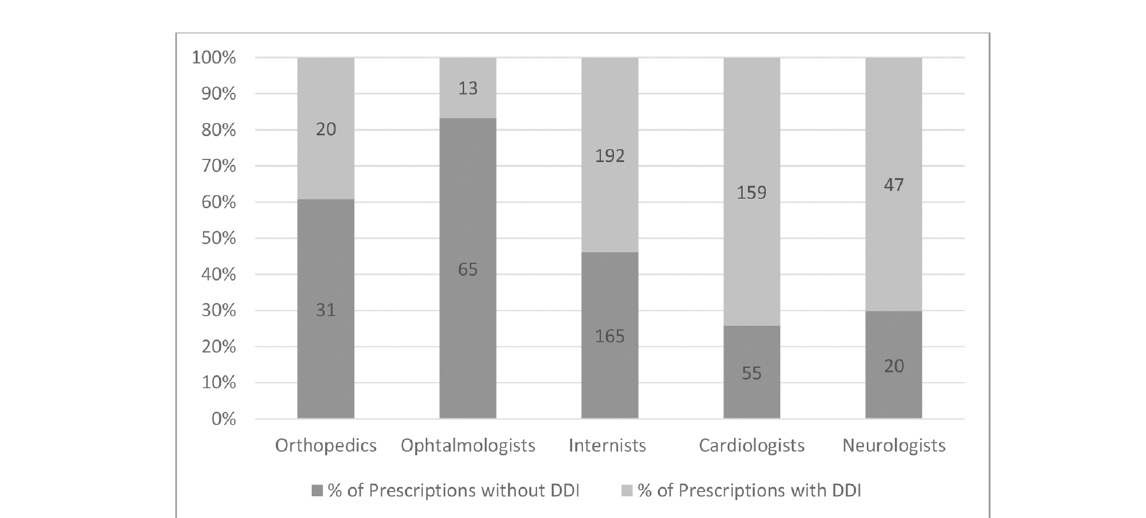
FIGURE 3 – Prevalence of clinically relevant (C, D and X) drug interactions within different specialties with >50 prescriptions.